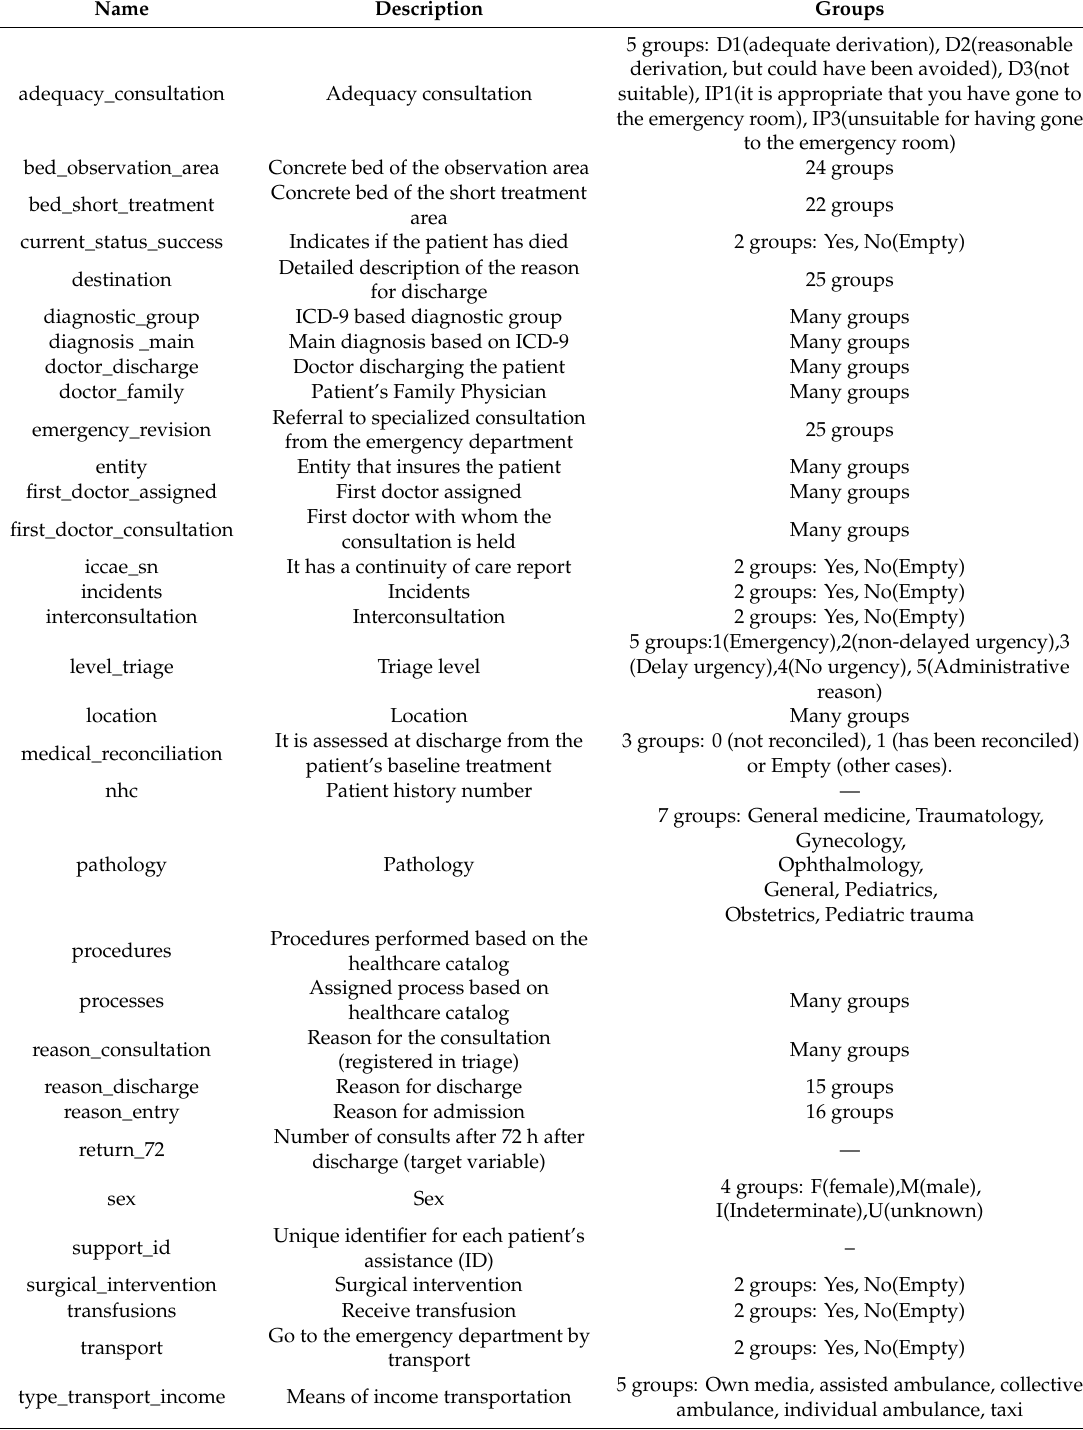
Table A3. Categorical